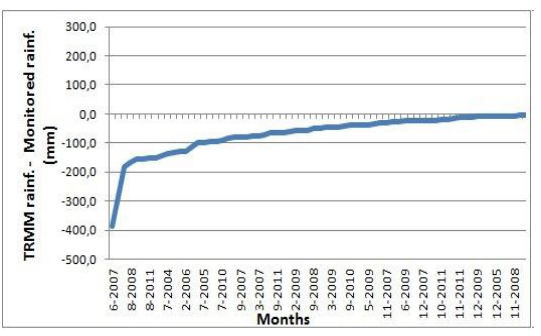
Figure 12. Monthly underestimation